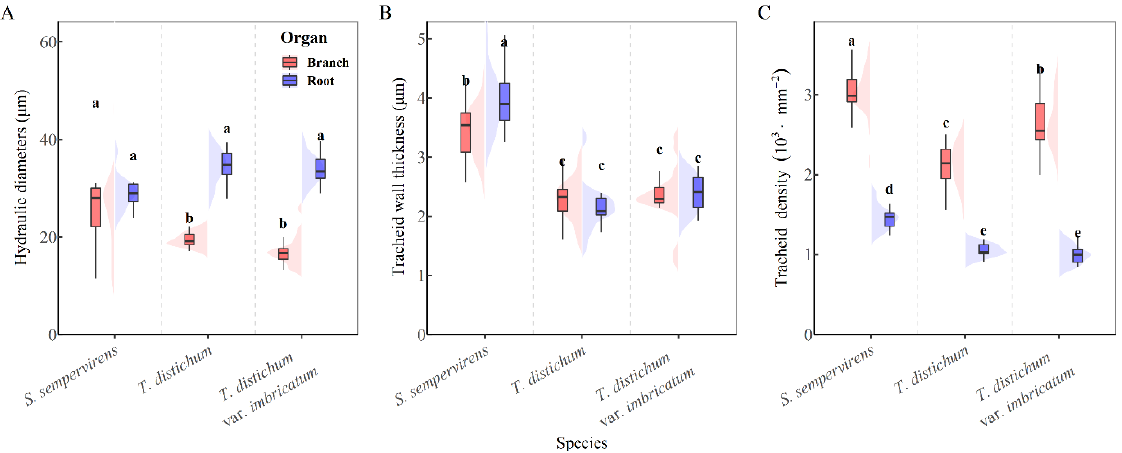
Figure 3. Hydraulic diameters ( D h , A ), tracheid wall thickness ( T , B ), and tracheid density ( N , C ) of the branches and roots in the three taxa. Different letters indicate a significant difference between means at p < 0.05 (multiple comparisons of treatments by means of a Tukey test).